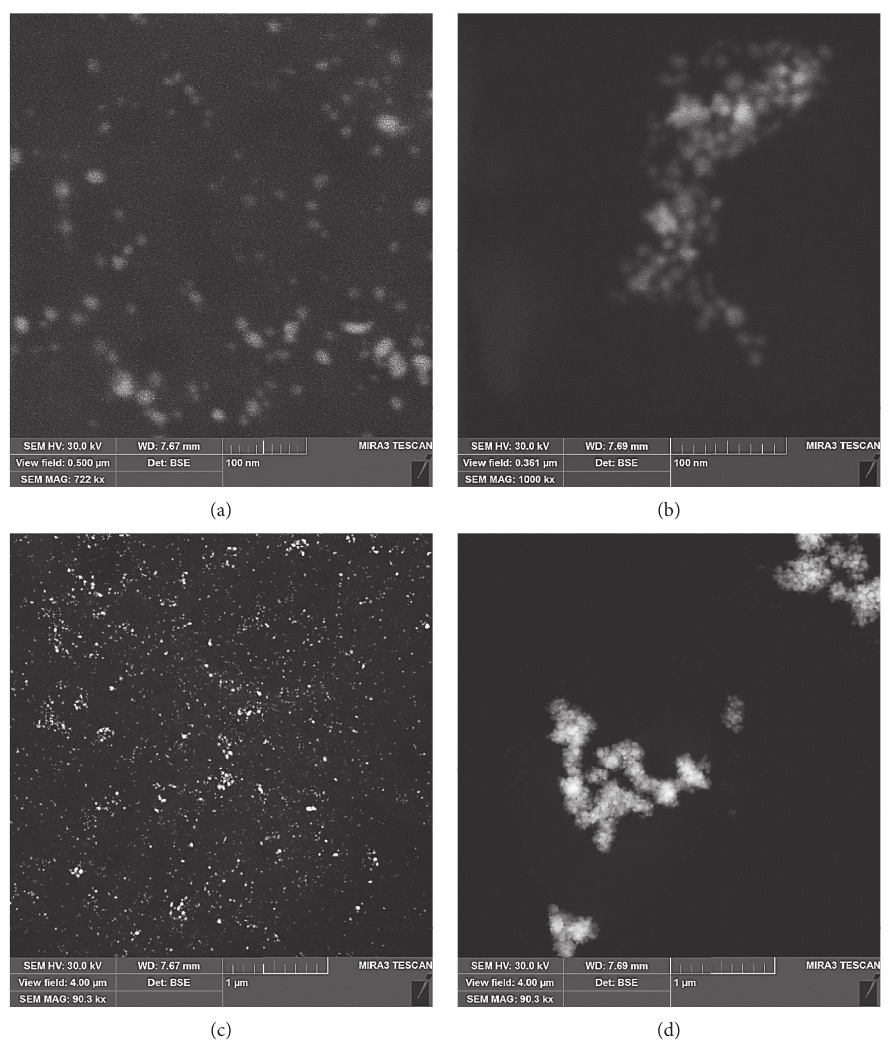
Figure 5: SEM images of obtained silver nanoparticles (C (Ag + ) � 10mmol/L, τ � 30min, and ratio AgNO and apricot pomaces (c, d) extracts (mL) �